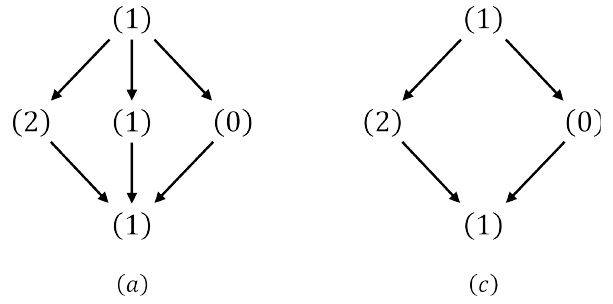
Figure 11: Representation (a) and (c) in Figure 7 repeated